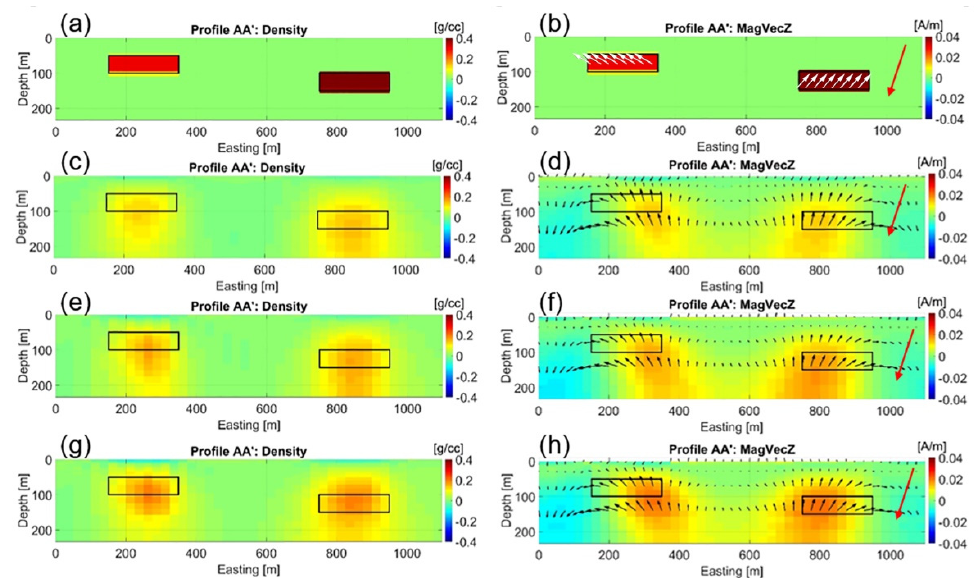
Figure 2. Panels ( a , b ) show the true density model and magnetization vector model, respectively. Panels ( c , d ) show vertical sections of the density and magnetic vector models inverted standalone, respectively. Panels ( e , f ) show vertical sections of the density and magnetic vector models inverted with Gramian constraints, respectively. Panels ( g , h ) show vertical sections of the density and magnetic vector models inverted with joint focusing constraint, respectively. Panels ( b , d , f , h ) show the vertical component of the magnetic vector in color; the full magnetic vector is shown by black and white arrows, and the direction of the inducing field is shown by red arrows.